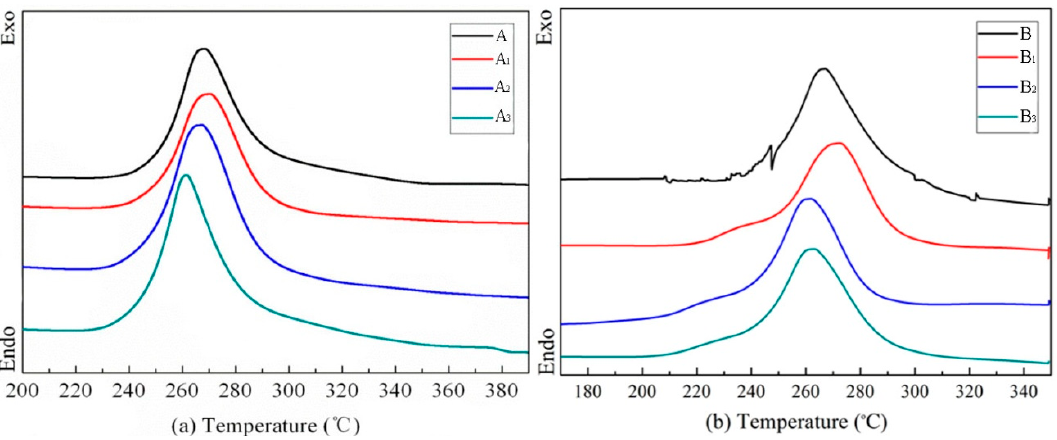
Figure 2. DSC curves of different diameter PAN fibers after modification. ( a ) Large diameter; ( b ) small diameter.